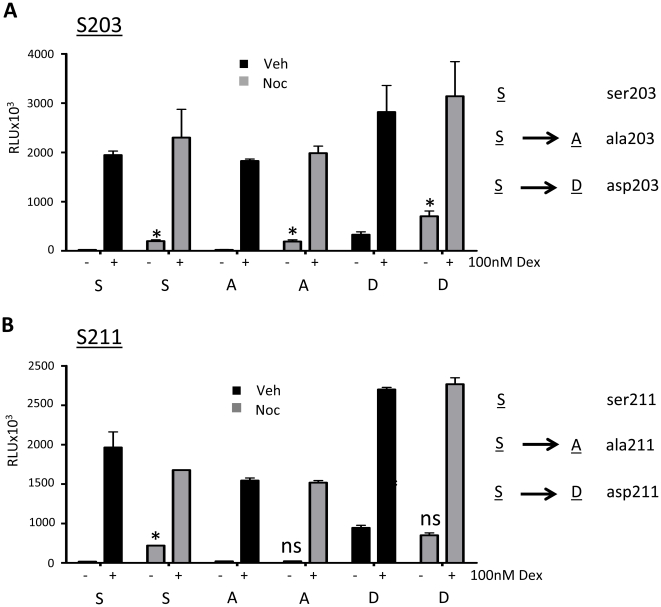
Mitosis driven phosphorylation modifies GR activity.To minimise confounding effects of wildtype endogenous GR in HeLa cells, GR deficient HEK cells were used in this instance. (A, B) HEK cells were co-transfected with 1 µg TAT3-Luc and 0.5 µg CMV-renilla (to control for transfection efficiency) together with either wildtype GR (S203GR, S211GR), a phosphorylation deficient receptor (A203GR, A211GR) or a phosphorylation mimic (D203GR, D211GR). 24 hours later, cells were treated with vehicle or nocodazole for 16 hours, then washed and treated with vehicle or dex for 16 hours. Cells were lysed, harvested and assayed for luciferase activity using a dual-luciferase reporter assay system. Graphs depict mean +/− SEM and are representative of three independent triplicate experiments. * indicates p<0.05 compared to vehicle control.